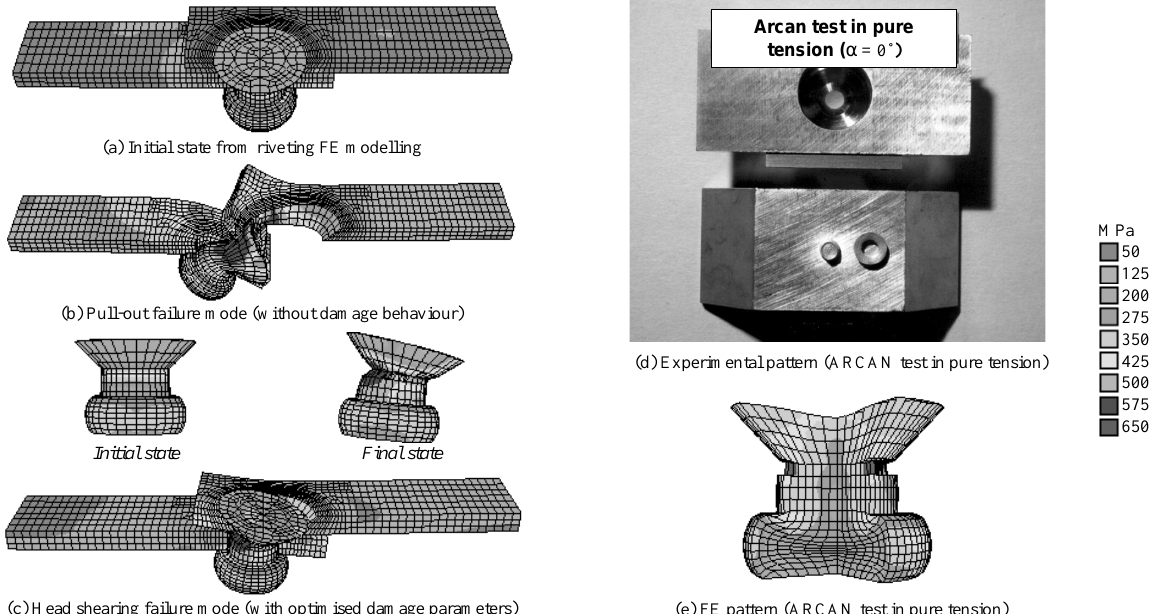
Fig. 20. Equivalent von Mises stresses – Single lap shear specimen and ARCAN specimen in pure